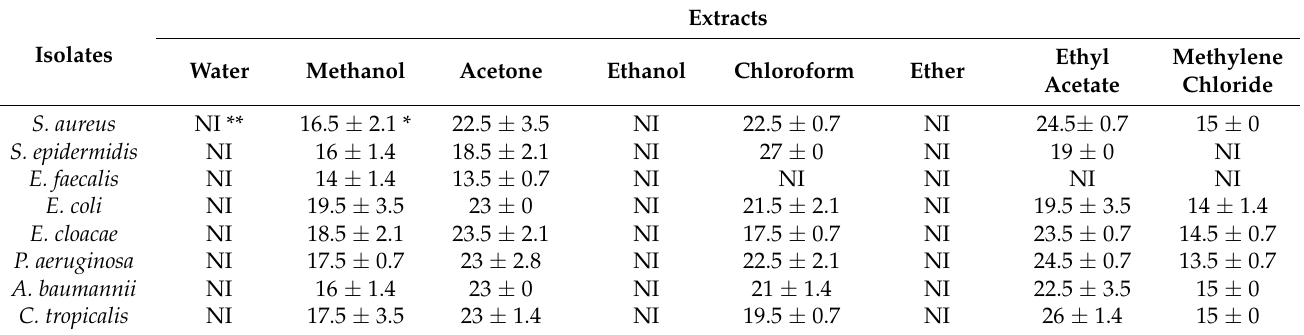
Table 3. Antimicrobial activity of different Solenostemma argel extracts against respiratory tract infection isolates measured as zone of inhibition diameter (ZOI, mm).